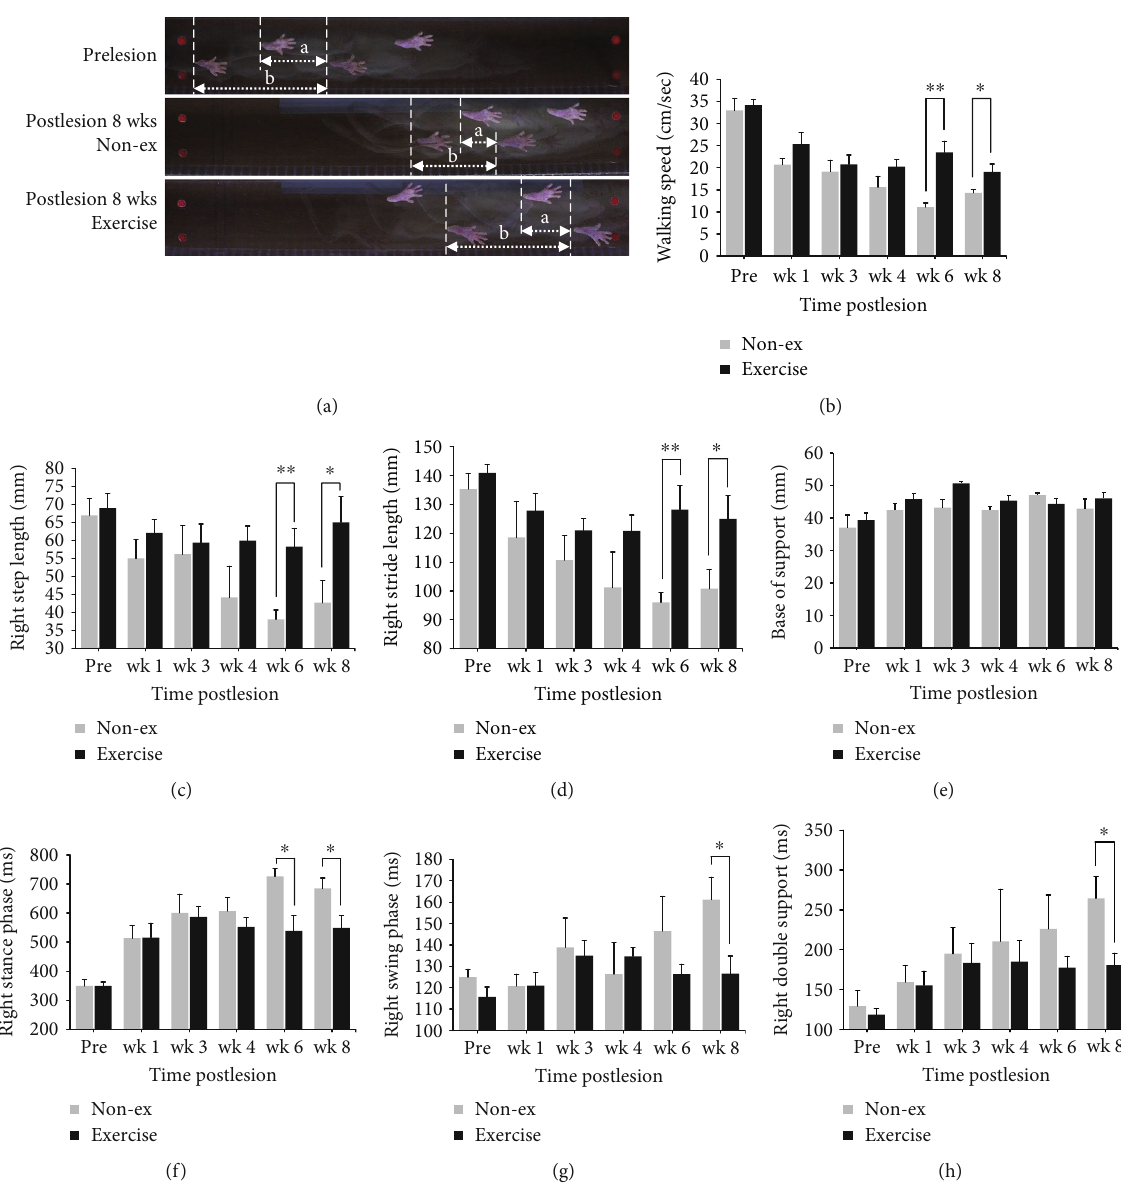
Figure 3: Characteristics of stepping footprint during 1 s walkway locomotion in a prelesion, an 8-week post-PD-lesioned rat with sham treatment, and an 8-week post-PD-lesioned rat following long-term exercise training (a). Time course changes of walking speed (b), step length (c), stride length (d), base of support (e), stance/swing phase time (f, g), and double support time (h) in the a ff ected hind limb in the sham and exercise training PD rats over an 8-week observation period. Note that the walking speed, step length, and stride length decrease signi fi cantly in the sham treatment group but show a less decrease in the exercise treatment group. ∗ p < 0 : 05 , ∗∗ p < 0 : 01 , and ∗∗∗ p < 0 : 001 , signi fi cant di ff erence between the two groups at each time